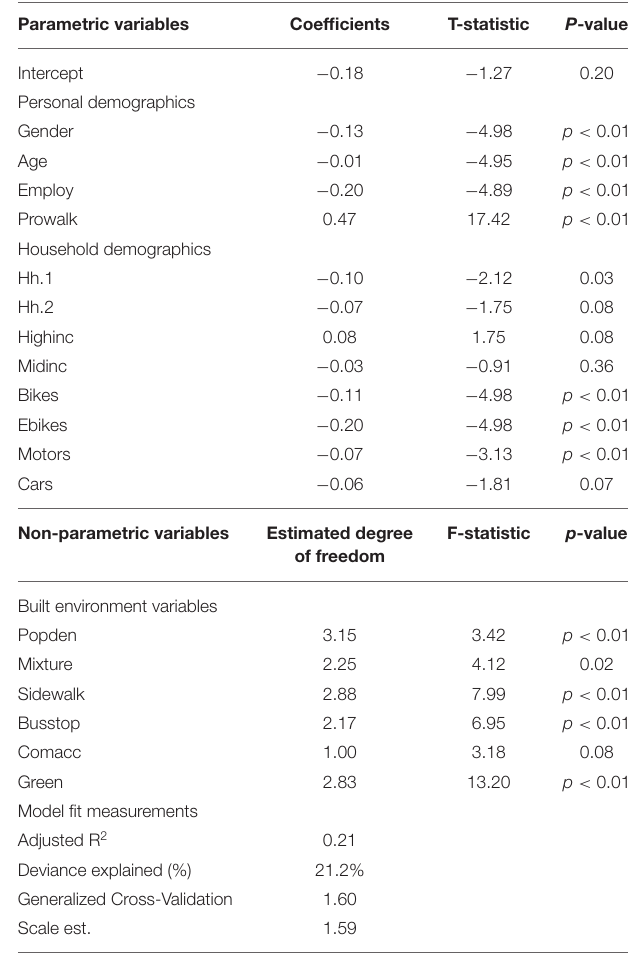
TABLE 4 | Description of variables used in the analysis. TABLE 5 | Results of the semi-parametric generalized additive mixed